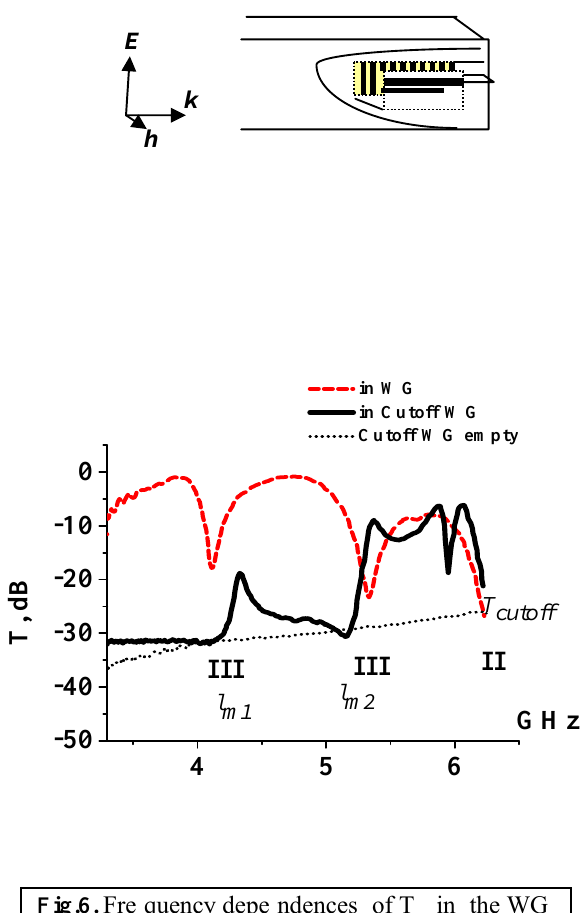
Fig.6. Fre quency depe ndences of T in the WG (dashed) and cutoff WG (solid) in the presence of metastructure with two